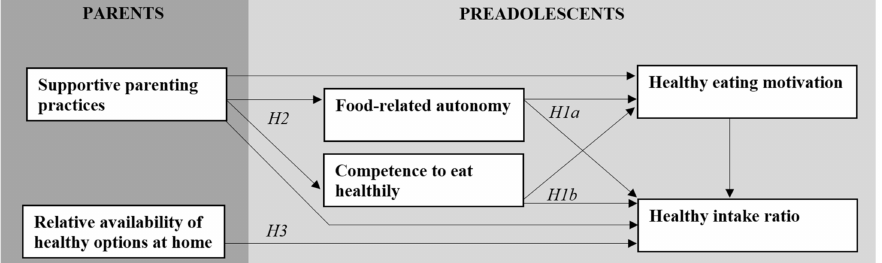
Figure 1. Conceptual model with hypotheses 1a (H1a), 1b (H1b), 2 (H2) and 3